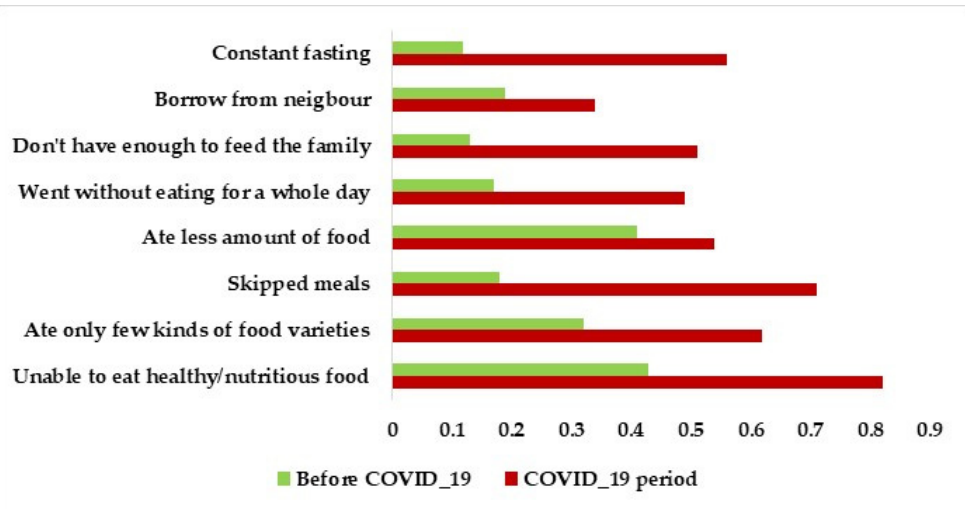
Figure 4. Percentage distribution based on perceived food security before and during COVID ‐ 19.